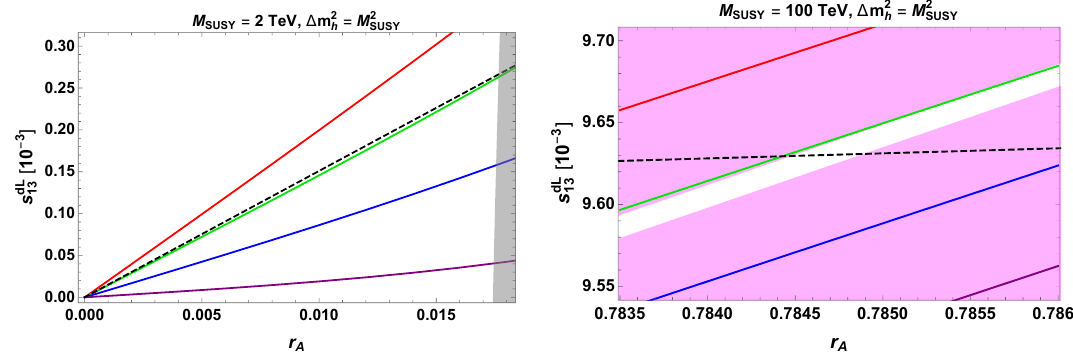
Figure 2 . The parameter spaces allowed by the EWSB and SUSY FCNC constraints in ( r A ; s dL plane. The magenta and gray shaded regions show the EWSB and SUSY FCNC constraints, respectively. The red, green, blue, and purple lines show the examples of prediction with di(cid:11)erent value of m 2 , which correspond to r h = 1 : 6, 1 : 605, 1 : 61, and 1 : 615 in the left panel and 1 : 843, 1 : 844, 10 1 : 845, and 1 : 846 in the right panel. The black dashed line shows the relation between s dL in each r A , which realizes the required SUSY threshold correction.